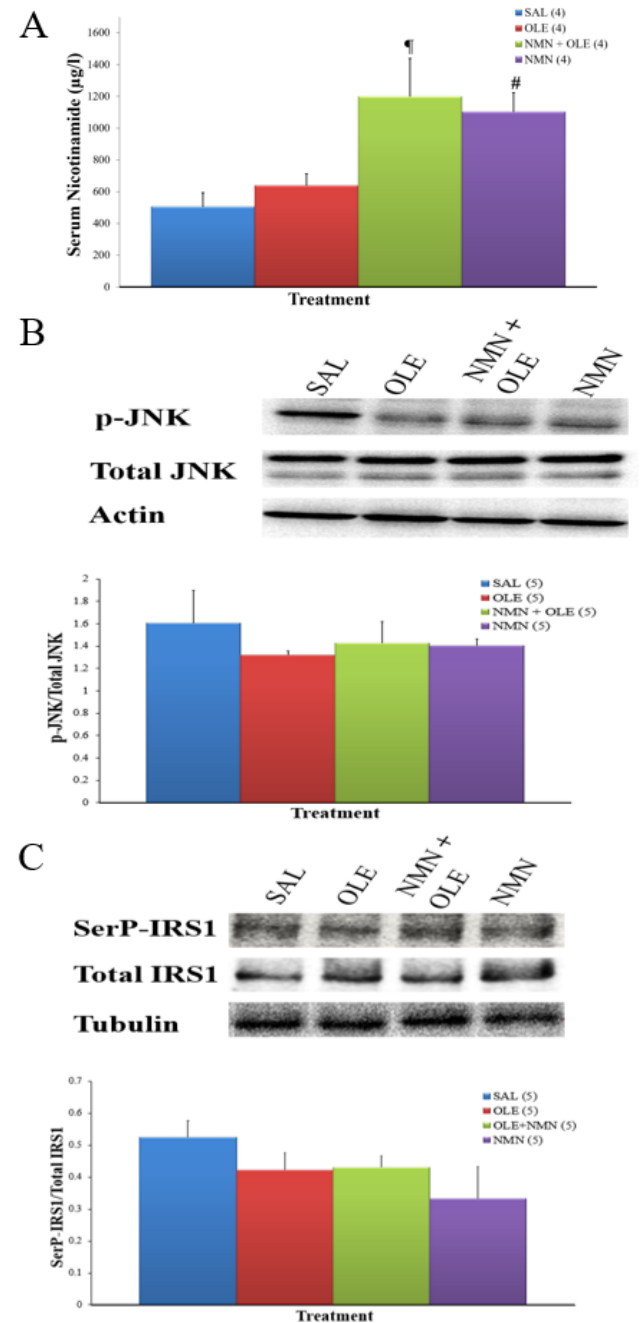
Figure 4. ( A ) Serum nicotinamide levels in mice after 48 h infusion. C57BL/6J mice were intrave- nously infused for 48 h with SAL, OLE (0.4 μ mol/min), NMN (0.025 mg·kg − 1 ·min − 1 ) + OLE, or NMN alone. Data are means ± SE. Number in parentheses represents number of animals. ¶ p < 0.05, SAL vs. NMN + OLE; # p < 0.05, SAL vs. NMN. Western Blot analysis of: ( B ) JNK phosphorylation and ( C ) IRS serine 307 phosphorylation in the livers of mice treated as described in Figure 4a. Because CEACAM1 and insulin clearance were decreased in mice only when NMN was co-infused with oleate, but not when NMN was infused individually, we further hy- pothesized that oleate may have accentuated the inhibitory effect of nicotinamide on SIRT2, which in turn would have resulted in decreased CEACAM1 and insulin clearance. However, the liver expression of SIRT2 was reduced by NMN but not by NMN + OLE, whereas SIRT1 expression was unchanged (Figure 5A,B).